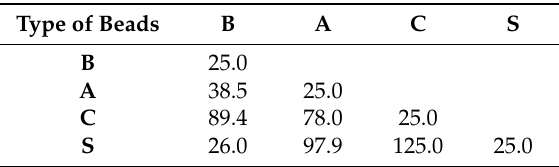
(in dissipative particle dynamic (DPD) units). ij